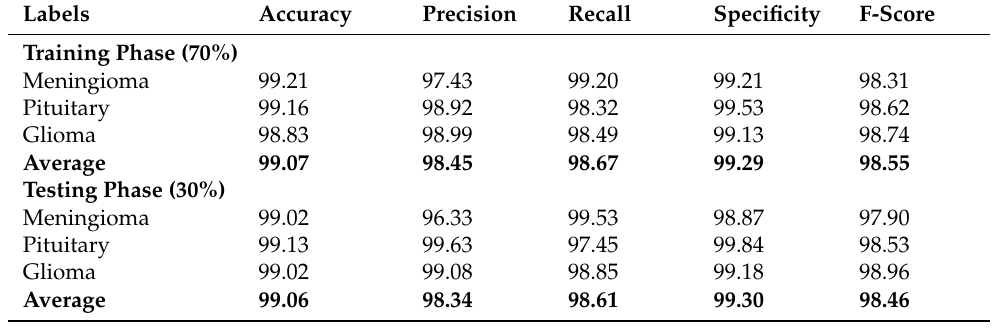
Table 3. Result analysis of EADL-BTMIC technique with various measures on 70% of TR and 30% of TS data.